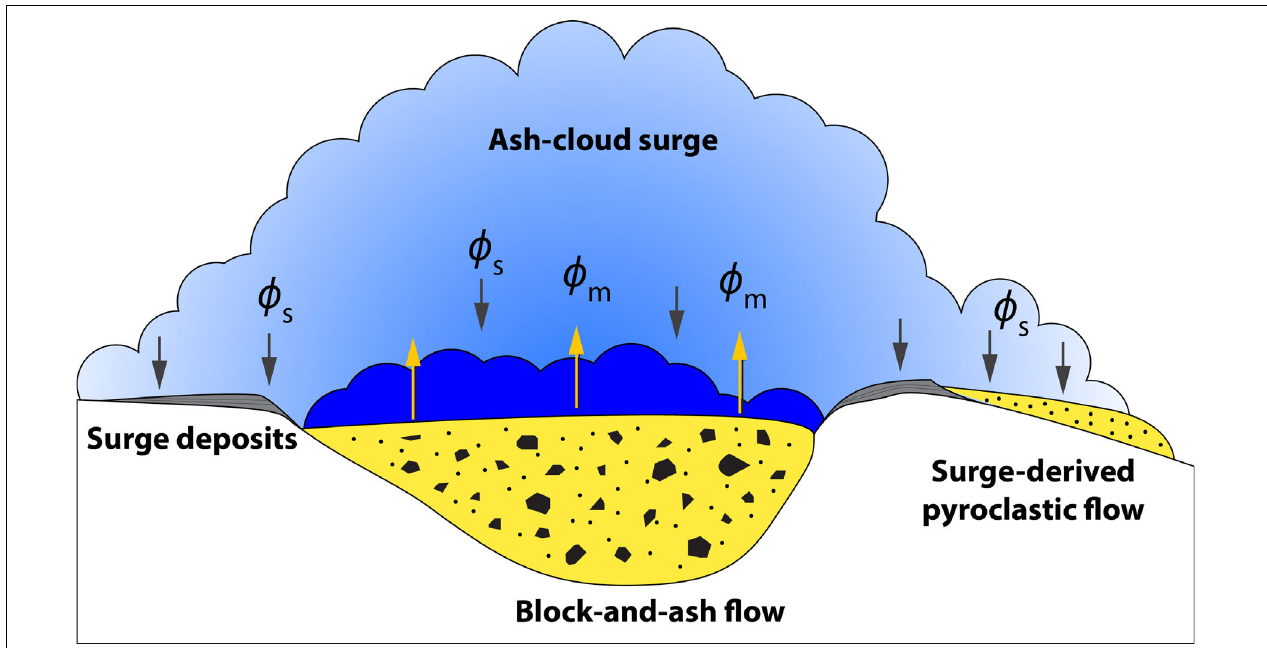
FIGURE 5 | Sketch of the general model of the two-phase version of VolcFlow (Kelfoun, 2017). The first layer simulating the block-and-ash flow feeds the second layer simulating the ash-cloud surge through the mass flux φ m . The second layer can either settle on the ground to form deposits or surge-derived pyroclastic flows, or incorporate back into the block-and-ash flow following the settling law φ s